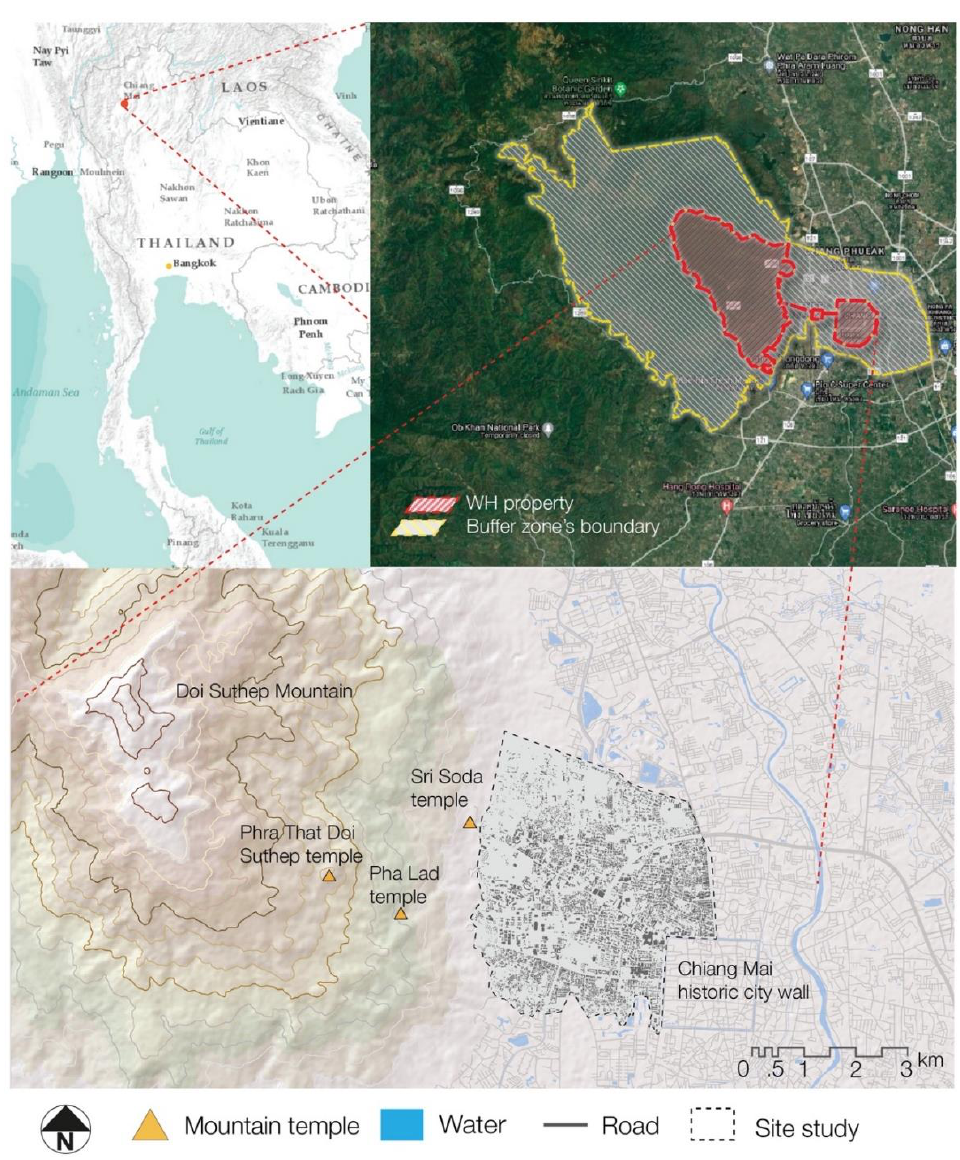
Figure 1. Location of site study area (Source: Authors).